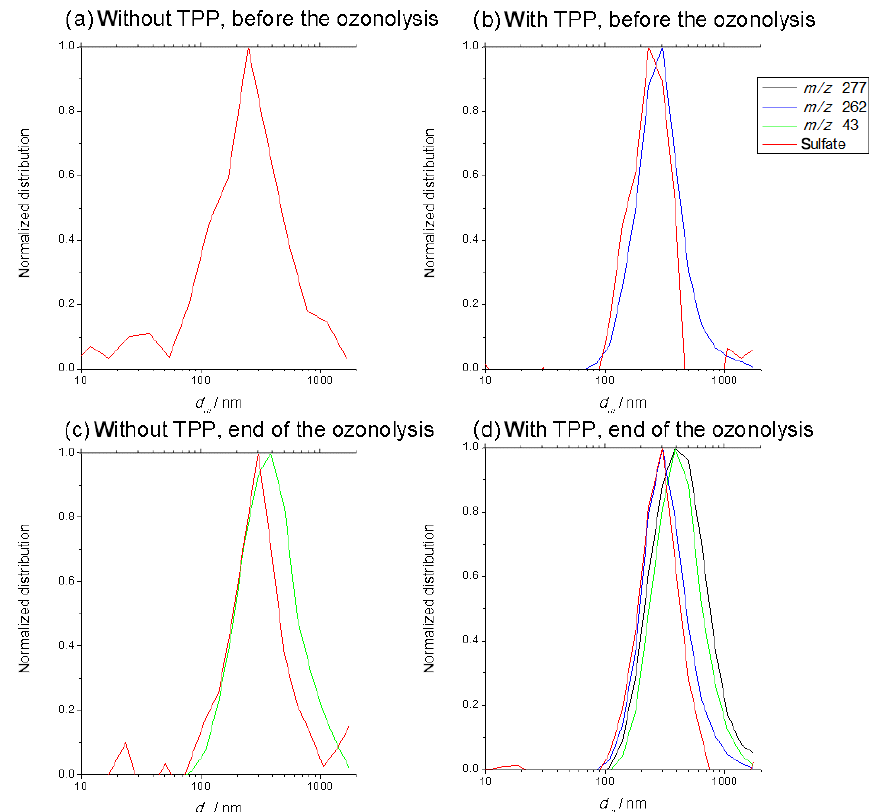
Figure 6. Size distribution of m/z 277 (black is TPPO), m/z 262 (blue is residual TPP), m/z 43 (green is SOA) and sulfate (red) for following periods: before the start of the ozonolysis (a) without and (b) with adding TPP and at the end (185–265min) of the ozonolysis (c) without and (d) with adding TPP. All distributions were normalized to their respective